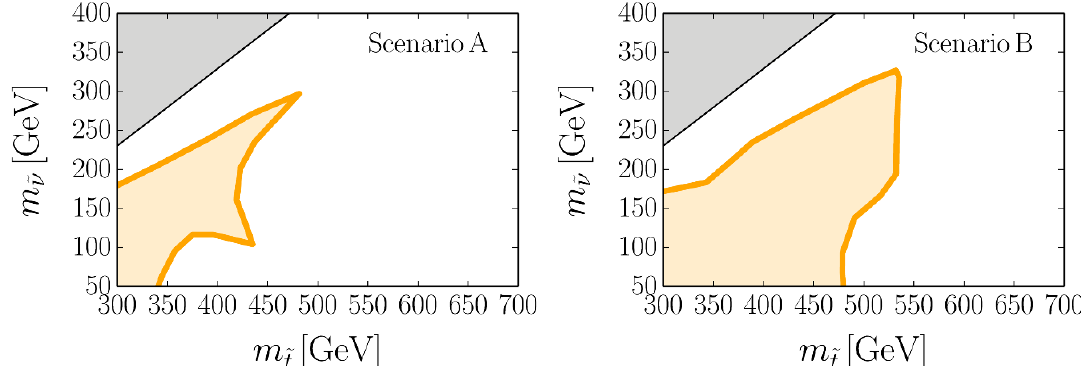
Figure 6 . 95% CL exclusion plots (inside the orange lines) for scenario A (left panel) and scenario B (right panel). The gray areas correspond to the region with m